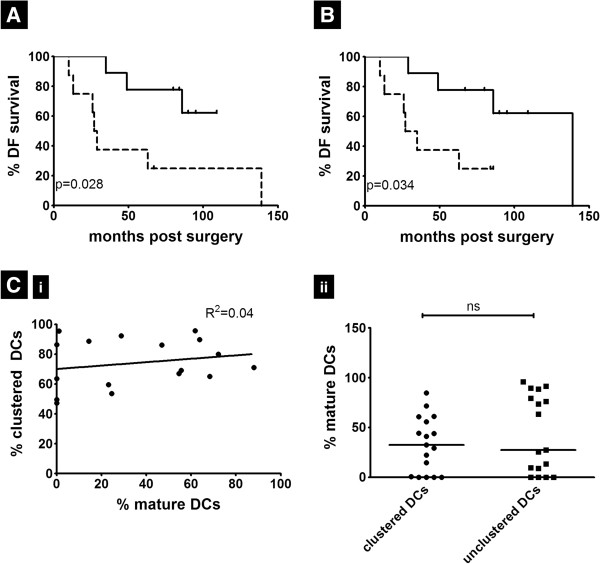
DC clustering and maturation in NSLN+ nodes correlate with duration of disease-free survival. Using the median value of (A) percentage mature DCs or (B) percentage clustered DCs per node as cutoff, patients having NSLN+ nodes (n=19) were divided into two groups (using exclusion criteria mentioned in the Methods section) with those above the median defined by the solid line and those below the median by the dotted line. Kaplan-Meier curves were plotted showing the difference in duration of disease free survival between the two groups. (C) (i) Linear regression analysis between %clustered DCs and %mature DCs in NSLN+ nodes (n=19) (ii) Percentage mature DCs were calculated among clustered as well as unclustered DCs in NSLN+ nodes (n=19) ns denotes p>0.05.